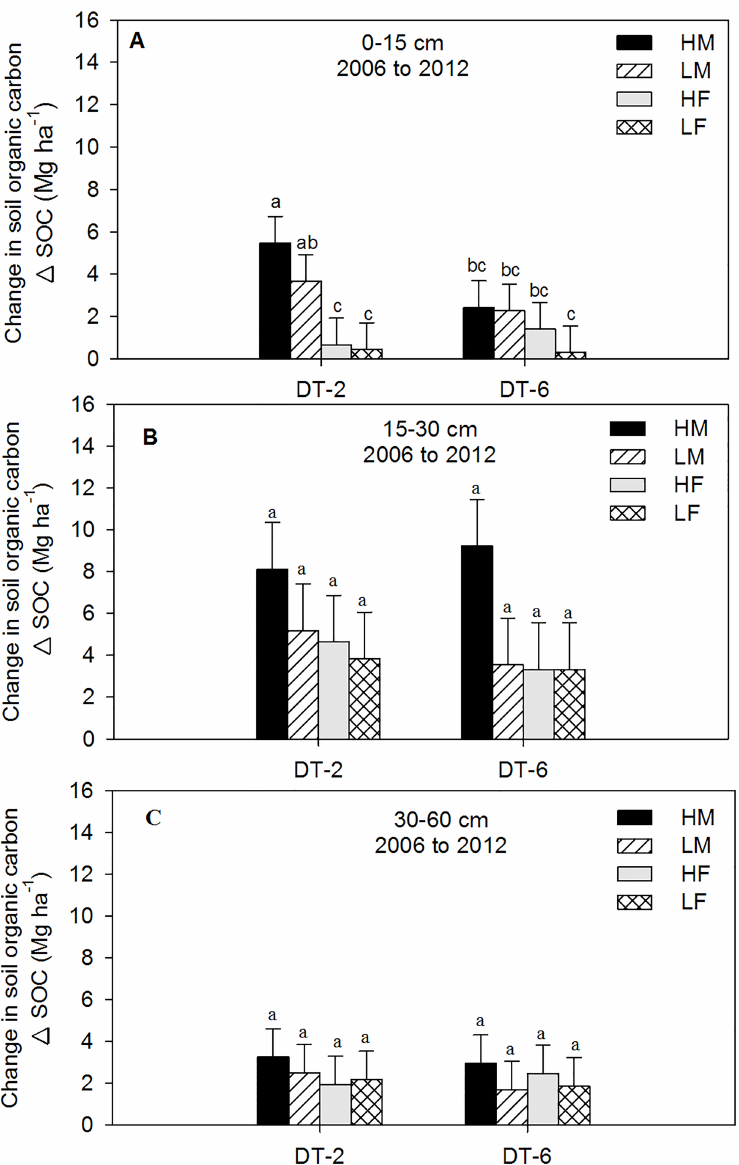
Fig 6. Change in soil organic carbon ( Δ SOC) measuredin Mg ha -1 from 2006 to 2012 as influenced by different N and deep tillage (DT). DT-2 represents biannualdeep tillage and manure(M) addition;DT-6 represents deep tillage and M additiononce every six years; HM treatment represents beef manureaddition at three times the recommended N (high) rate; LM treatment represents beef manure additionat the recommended (low) rate; HF treatment represents inorganicfertilizer (urea) additionat doublethe recommended N (high) rate; LF treatment represents inorganicfertilizer (urea) additionat the recommended (low) rate; C treatment representsno nitrogenaddition(control). (A) represents 0–15cm; (B) represents15– 30 cm; and (C) represents 30–60 cm. The error bars represent standard errors of the mean. The different lowercaseletters represent significantdifferences amongN treatments (P <